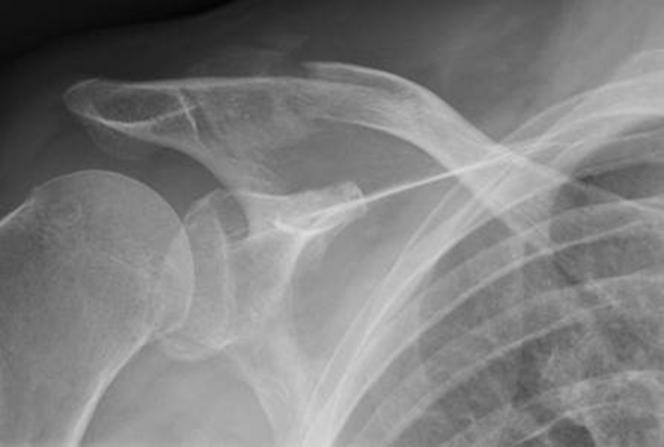
Radiograph of patient with painful nonunion.